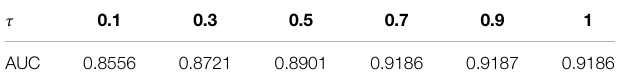
TABLE 2 | The AUC value using different τ values while fi xing λ 1 (cid:2) 0 . 1 and λ 2 (cid:2) 0 .